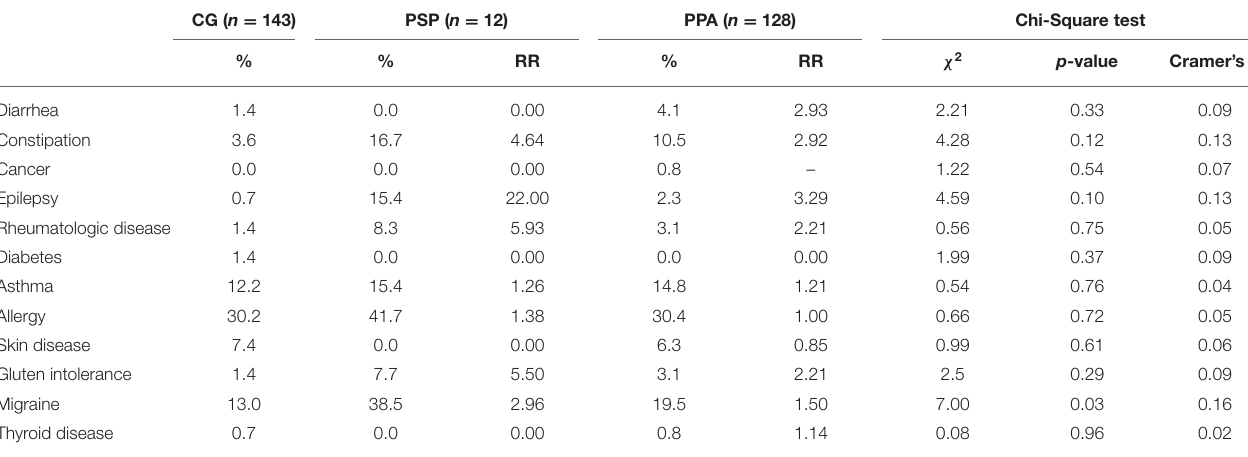
TABLE 6 | Prevalence and risk ratio (RR) of defined somatic symptoms and diseases according to psychosocial